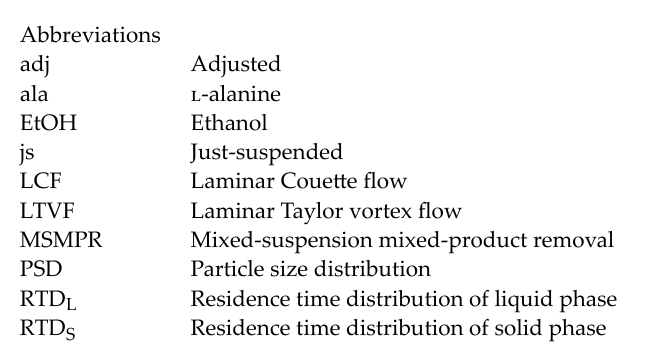
pension viscosity. Figure S1: Microscopic images showing sieved L‑alanine crystals from stock of sieve fraction 315–400 µ m. Figures S2–S7: Just‑suspended rotational Reynolds numbers Re θ , js as a function of particle weight fraction for the geometries η = 0.5–0.84. Table S1: Experimental data of the conducted flow transition experiments. Table S2: Experimental data of the conducted par‑ ticle suspension experiments. Table S3: Experimental data of the conducted RTD L